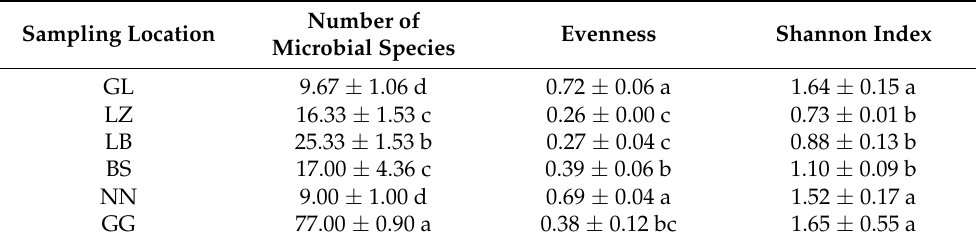
Table 2. Bacterial diversity index, evenness index, and abundance of different